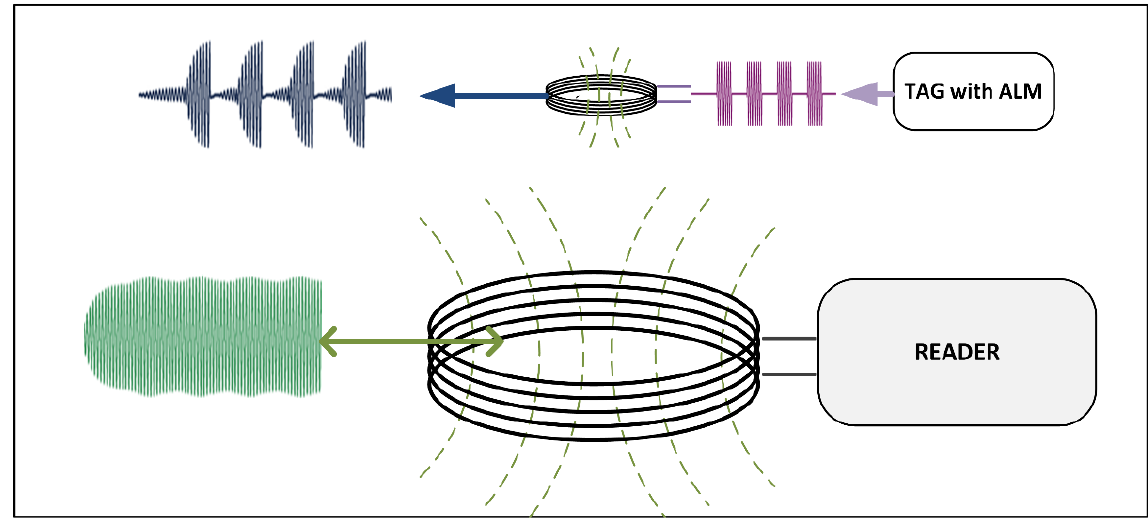
Figure 1. A communication pair composed of a reader and a tag with active load modulation (ALM). The tag transmits a modulated carrier signal, which is transformed into a magnetic field and combined with the reader’s magnetic field. When ALM is performed correctly, the reader cannot distinguish between a tag with ALM and a passive tag.